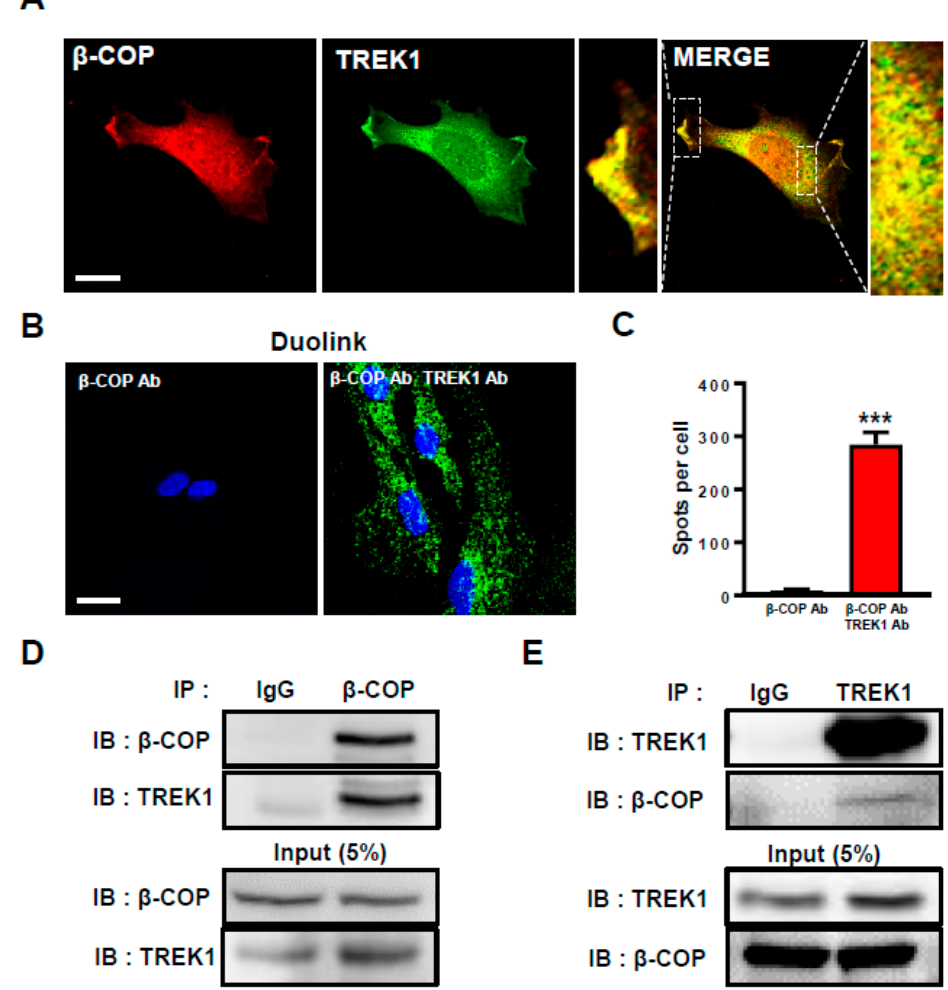
Figure 1. β -COP associates with TREK1 in astrocytes. ( A ) Representative immunocytochemical images of astrocytes stained with anti- β -COP and anti-TREK1 antibodies. Enlarged images on either side of the merged image indicate co-localization of β -COP and TREK1 in the plasma membrane and inside of astrocytes. Scale bar, 20 µ m. ( B ) Duolink PLA assay. Intense PLA signals were detected in anti- β -COP antibody and anti-TREK1 antibody exposed astrocytes, but not in anti- β -COP only exposed astrocytes. Scale bar, 20 µ m. ( C ) The PLA signals were counted with Image J software and the average number of spots per cell is presented in the graph. The number at the bottom of each bar indicates n. ( D ) Co-immunoprecipitation (Co-IP) assay in astrocytes. Whole-cell lysates were immunoprecipitated using anti-TREK1 and then blotted using anti- β -COP. ( E ) The reverse is immunoprecipitated using anti- β -COP and then blotted using anti-TREK1. All values are mean ± SEM (*** p < 0.001). SEM, standard error of the mean.